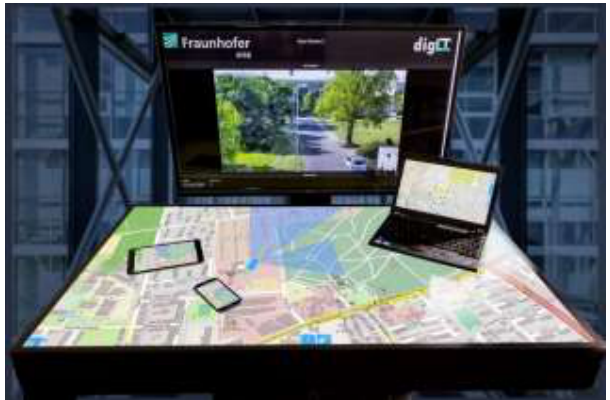
Figure 3: The map is shown on the table display, the additional information is displayed on the vertical